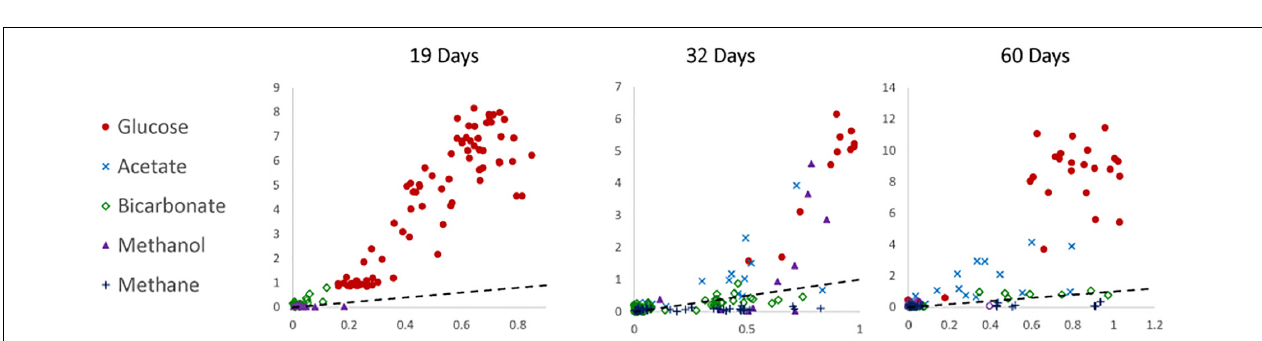
FIGURE 2 | NanoSIMS images of microbial cells incubated with 13 C-labeled carbon sources and 15 NH 4 Cl for 32 days under anoxic conditions. The top row illustrates 12 C 14 N ion counts that identify microbial cells. The middle and bottom rows show which of those microbial cells assimilated 13 C and 15 N, respectively, with warmer colors indicating a higher degree of